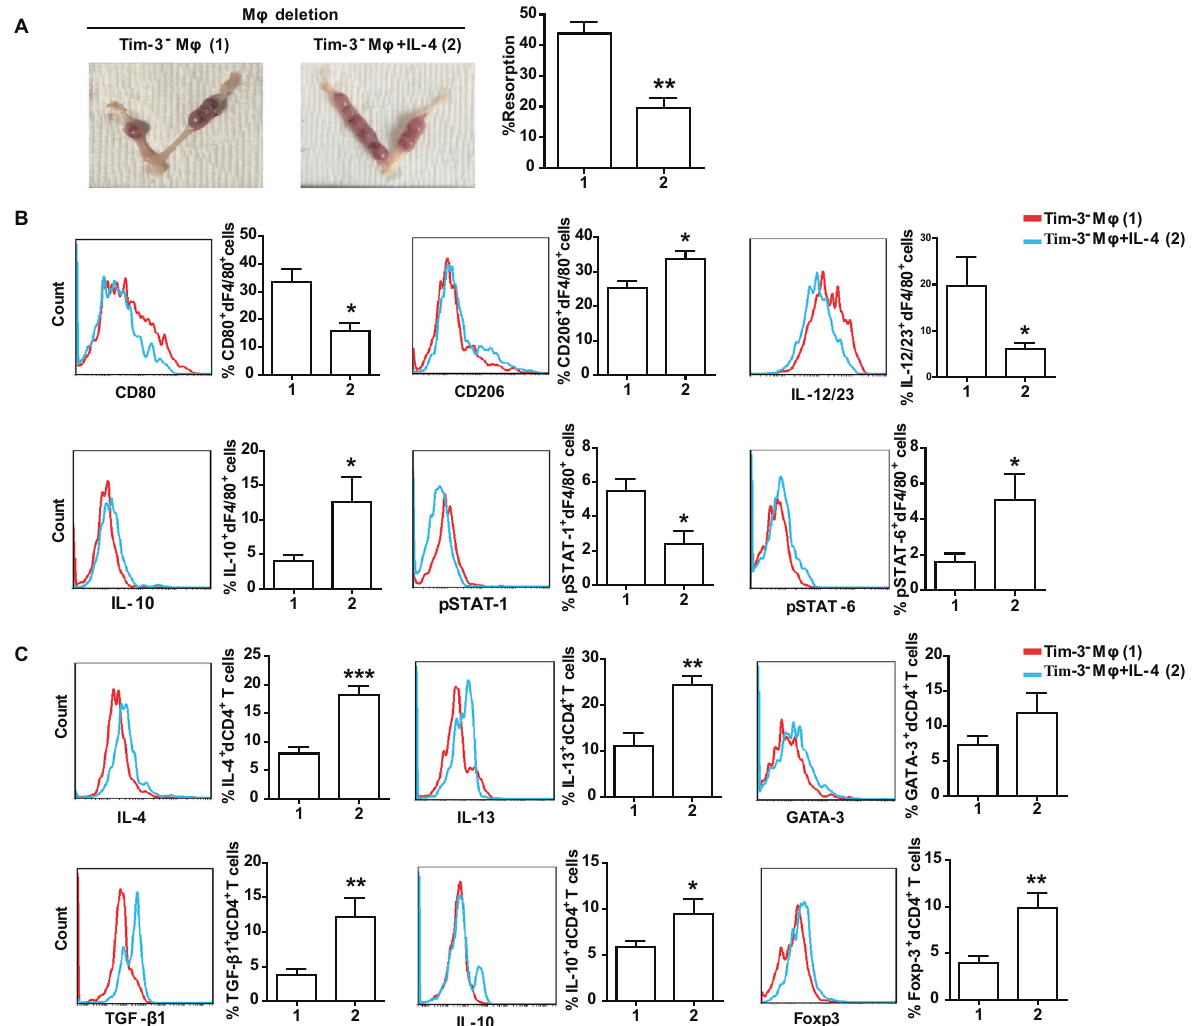
Fig. 7 IL-4 treated Tim-3 − M φ s also relieved murine embryo absorption induced by M φ depletion. A Representative images of uterus and the percent of fetal resorption in pregnant CBA/J mice with M φ depletion that received adoptive transfer of indicated Tim-3 − M φ s. B Flow cytometric analysis and quanti fi cation of frequency of surface molecule, cytokine and transcription factor expression by dF4/80 + cells from pregnant CBA/J females with M φ depletion that received adoptive transfer of indicated Tim-3 − M φ s. C Quanti fi cation of fl ow cytometric analysis of cytokine production and transcription factor expression by dCD4 + T cells from pregnant CBA/J females with M φ depletion that received adoptive transfer of indicated Tim-3 − M φ s. Data represent the mean ± SEM of n = 6 – 9 mice per group. * p < 0.05, ** p < 0.01, compared with the Tim-3 − M φ s